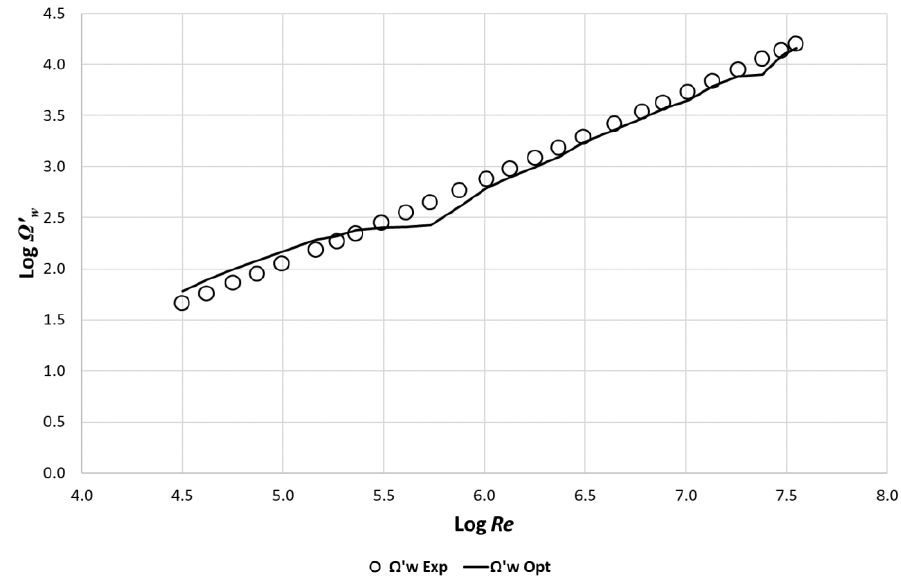
Figure 16. The comparison of the normalized wall vorticity obtained by four variables optimiza- tion with experimental data.